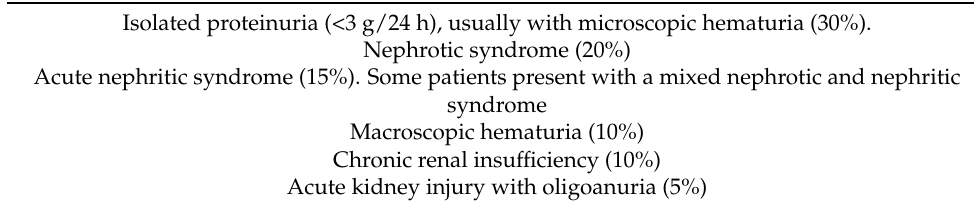
Table 4. Clinical presentations of patients with Cryoglobulinemic nephritis